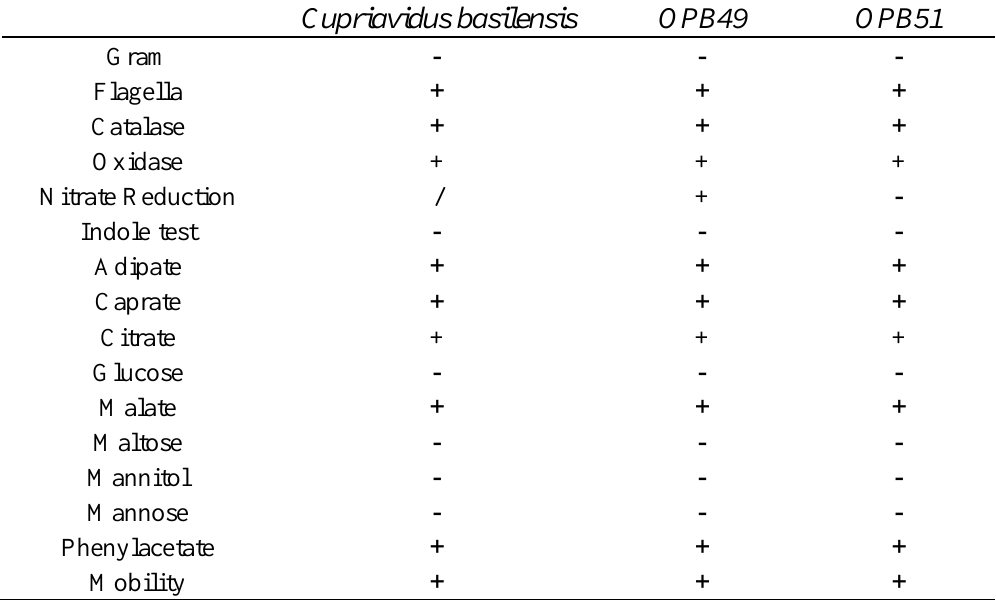
Table 2. Biochemical characteristics of OPB 49 and OPB